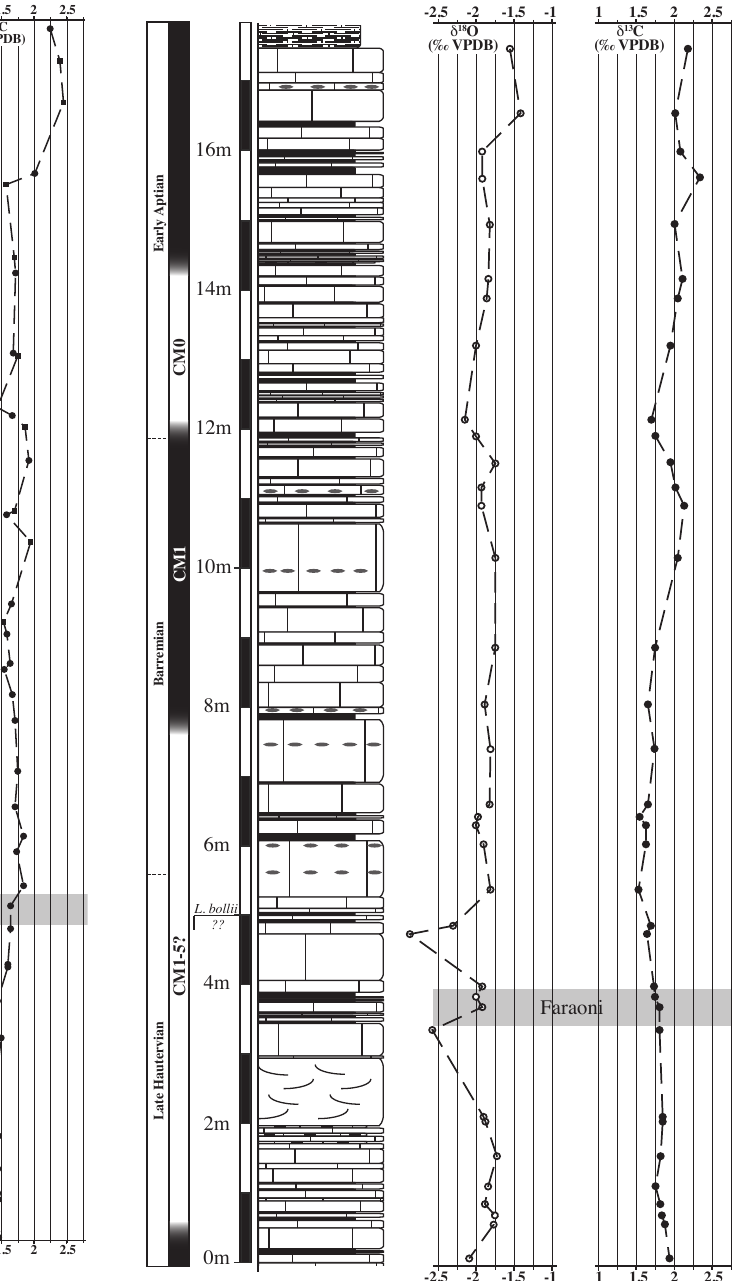
Fig. 5. The Breggia section: stable-carbon and oxygen-isotope val- ues for carbonate (open and closed circles) and mudstone samples (open and closed rectangles).